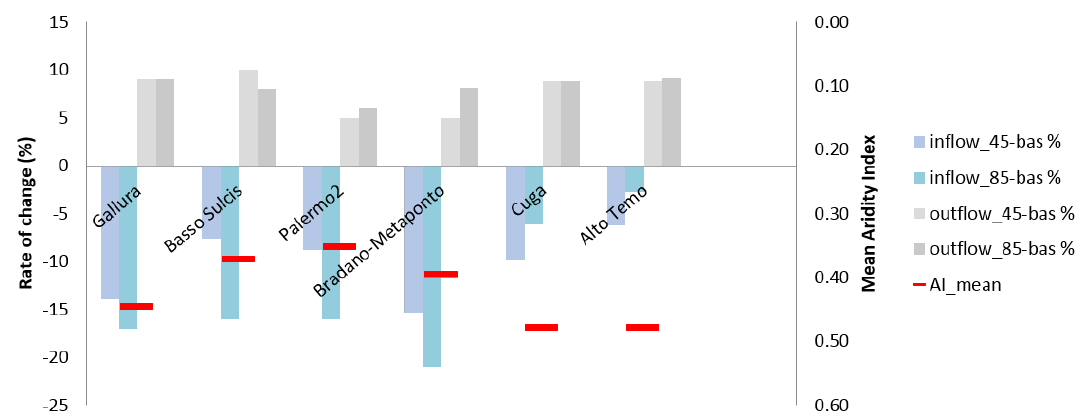
Figure 4. Rate of change in water inflow and outflow between future under RCP 4.5 and 8.5 (bars, left axis), and baseline together with the aridity index (lines, right axis). Aridity Index (AI) is calculated as the ratio of annual precipitation over reference evapotranspiration, and is displayed as average over the 1976–2005 period (AI mean). Data are shown per each Ir-Ds. Table 7. Crop water demand ( WD ) and evaporation from the open surface, in each case study. Values are expressed in Mm 3 and shown for the baseline and future period, under RCP 4.5 and 8.5 scenarios. Baseline Irrigation District Reservoir